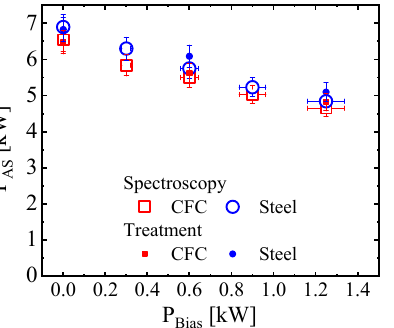
Figure 3. AS plasma power as a function of bias plasma power for steel AS ( Φ CH4 = 4 slh), indicated in blue, and CFC-AS, indicated in red, at H 2 :N 2 = 1:1, p = 3 mbar, T = 460 °C, and Φ Total = 80 slh (closed symbols: extracted during material treatments; open symbols: extracted during the spectroscopic investigations).